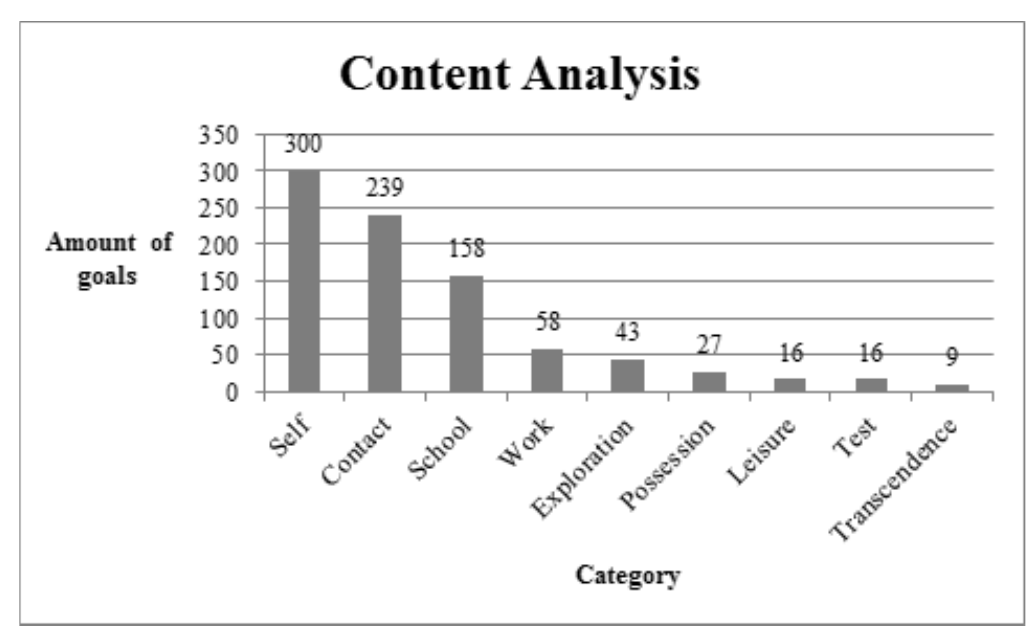
Figure 1. Content Analysis of